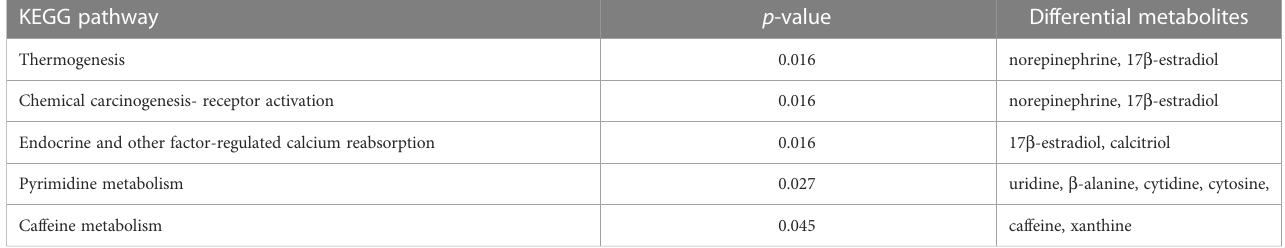
TABLE 2 The top fi ve altered metabolic pathways in Ano5 Cys360Tyr mCOBs compared to wild type mCOBs.